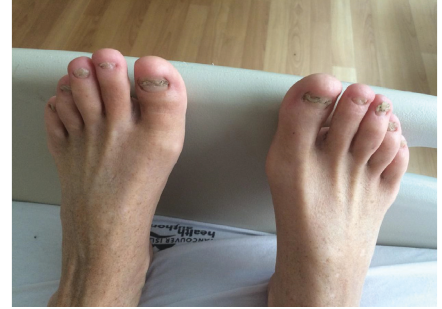
Figure 1: Onchodystrophy of